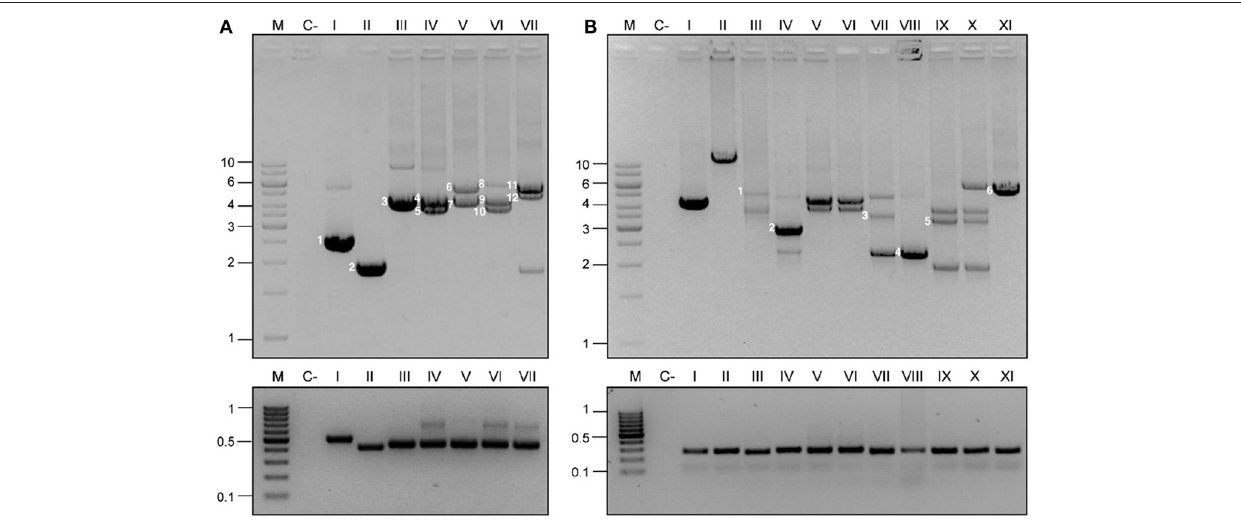
FIGURE 3 | Detection and capture PCR for ColE1 plasmids. ColE1 detection (bottom) and capture (top) PCRs in Pasteurellaceae (A) and Enterobacteriaceae (B) . M stands for molecular weight marker and numbers to the left of the panels indicate the size in kb. C- Stands for negative control. The lanes correspond to different strains and are indicated with roman numbers. (A) Pasteurellaceae family PCRs. Negative control (c-) corresponds to H. influenzae RdKW20. The products of the capture PCR, corresponding to the ColE1 plasmids carried by the strains, are indicated by numbers. Lane I, P. stomatis BB1086: pB000a (1). Lane II, Frederiksenia canicola BB1087: pB000b (2). Lane III, H. influenzae BB1059: pB1000 (3). Lane IV, P. multocida BB1035: pB1000 (4) and pB1005 (5). Lane V, P. multocida BB1041: p9956 (6) and pB1000 (7). Lane VI, P. multocida BB1044: pB1000 (9), pB1005 (10) and pB1006 (8). Lane VII, P. multocida BB1046: pB1002 (11) and pB1003 (12). (B) Enterobacteriaceae family PCRs. Negative control (c-) represents E. coli DH5 α . Lanes I and II correspond to ColE1 based cloning vectors pTOPO and pUC19 (with the insertion of a ∼ 13kb DNA fragment), respectively. Lanes III to XI correspond to wild type strains from the Sanjay Gandhi Postgraduate Institute of